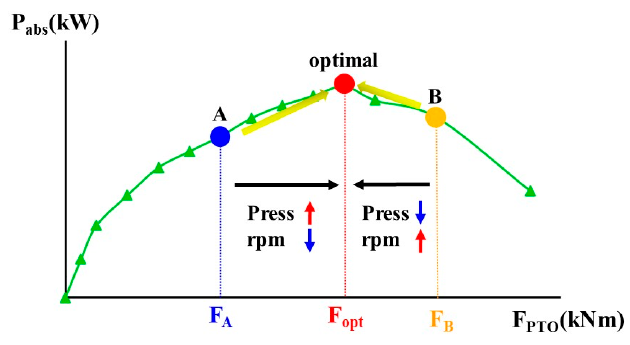
Figure 5. P&O algorithm-based power versus PTO force.